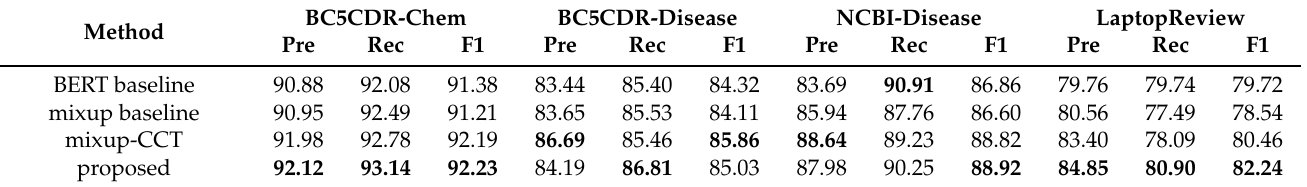
Table 2. Results of the test set’s span-level Precision/Recall/F1-score when the F1-score for the Dev set was the highest during training. The best performance is bolded. Pre, rec, and F1 mean a Precision, Recall, and F1-score,